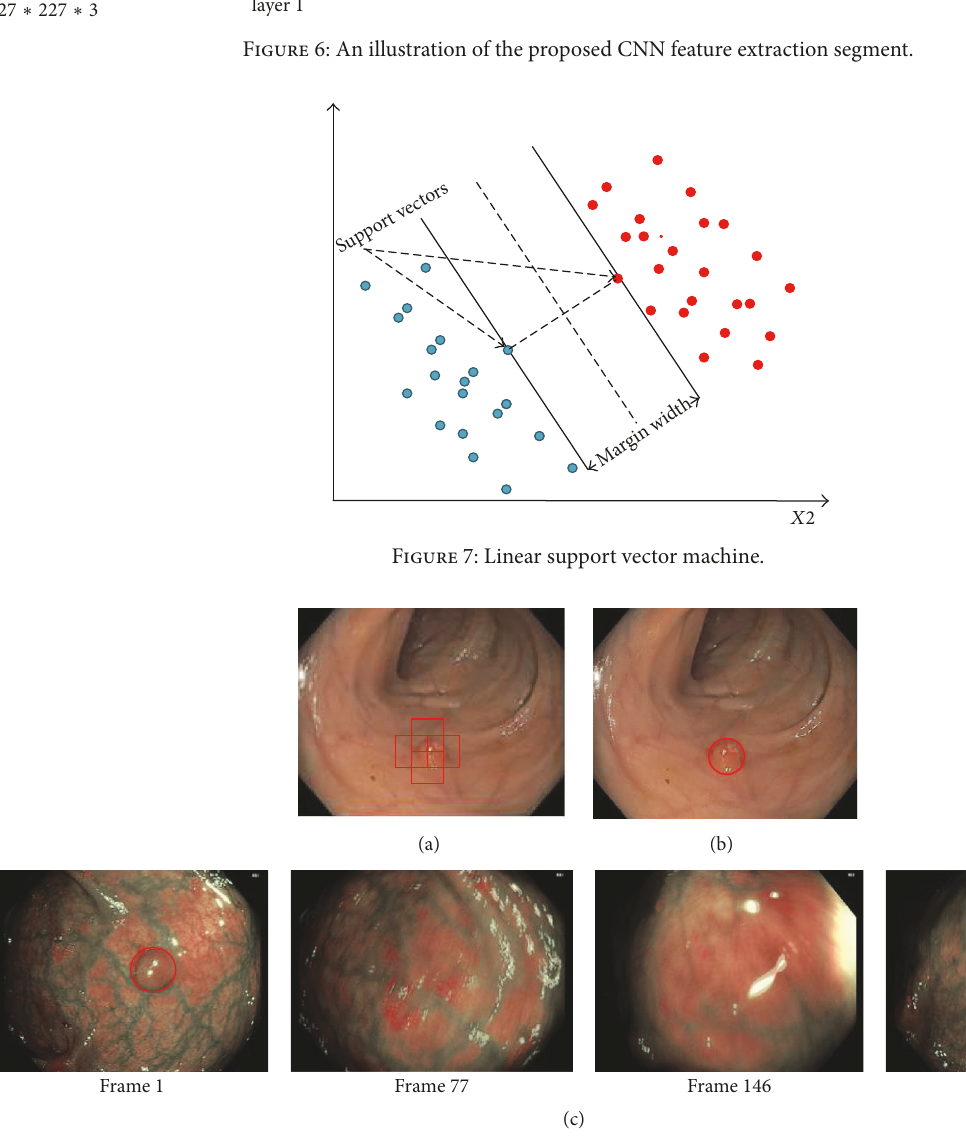
Figure 8: Output segment: (a) several portions are marked to be possible polyp, (b) system’s output after processing, and (c) output video